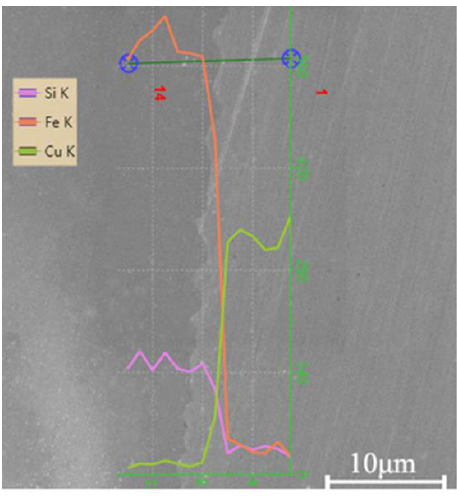
Figure 14. EDS concentration curve for laser impact welding of crystal and amorphous materials [52].